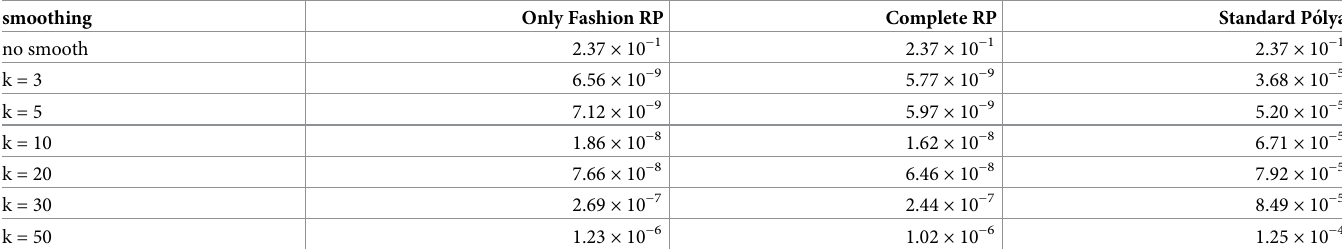
Table 19. “10 days of traffic” ( T = 0, entire, D = 30 00 , S = 100 slots of equal size): MSE for different levels of smoothing.